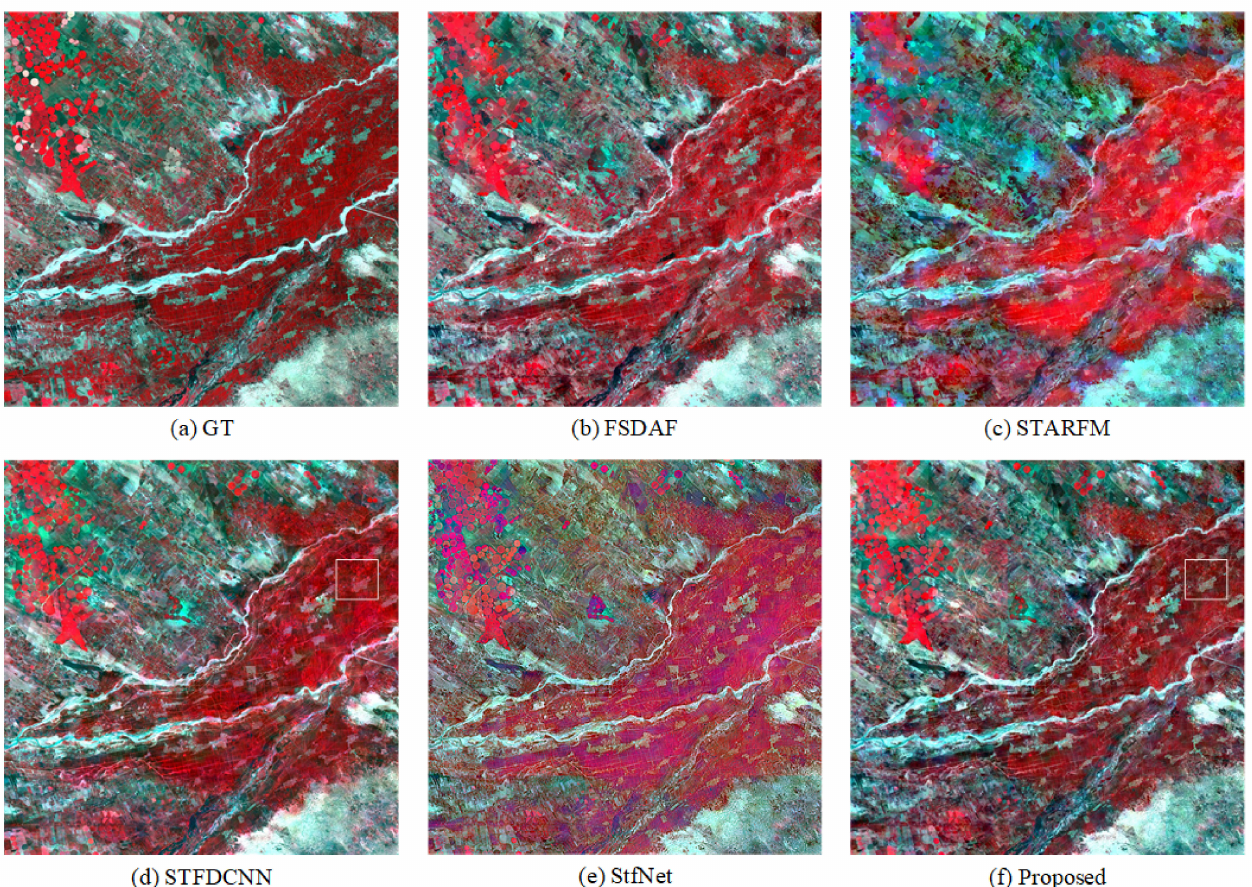
Figure 9. Full prediction results for the target Landsat image (7 July 2015) in the AHB [32,33] dataset. Additionally, comparison methods include FSDAF [13], STARFM [8], STFDCNN [18], and StfNet [19], which are represented by ( b – e ) in the figure respectively. In addition, ( a ) represents the ground truth (GT) we got, and ( f ) represents the method we